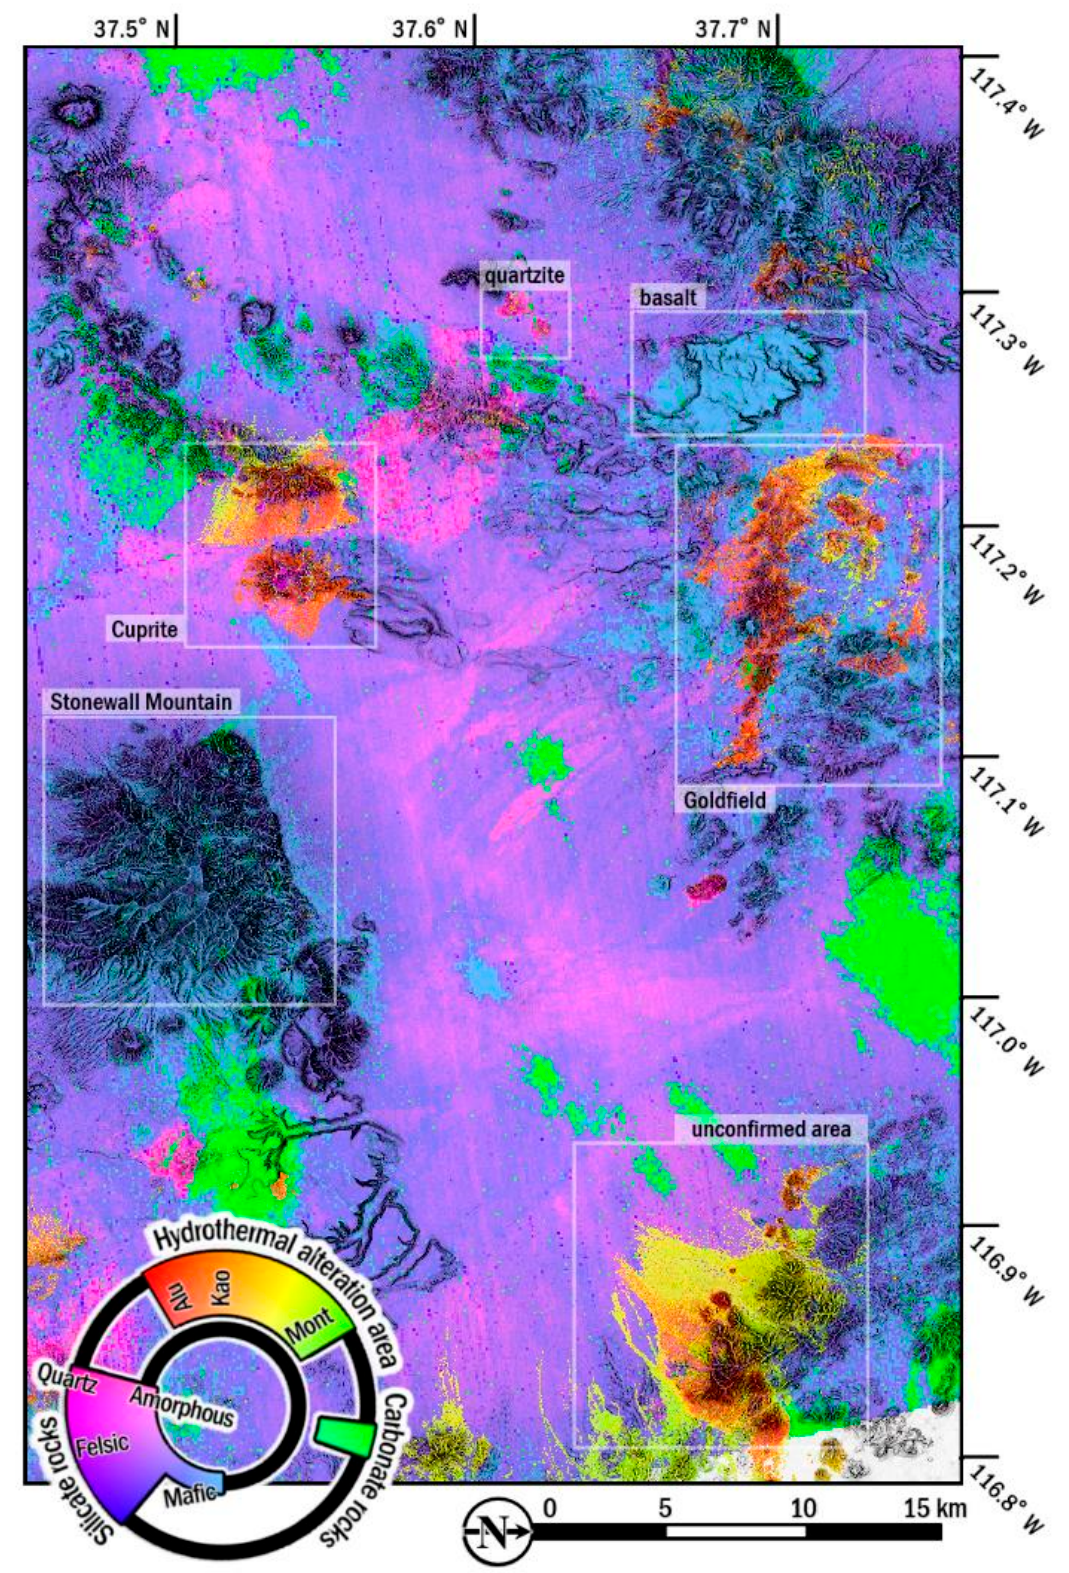
Figure 6. Integrated image simultaneously exhibiting multiple lithological indices and the topography.